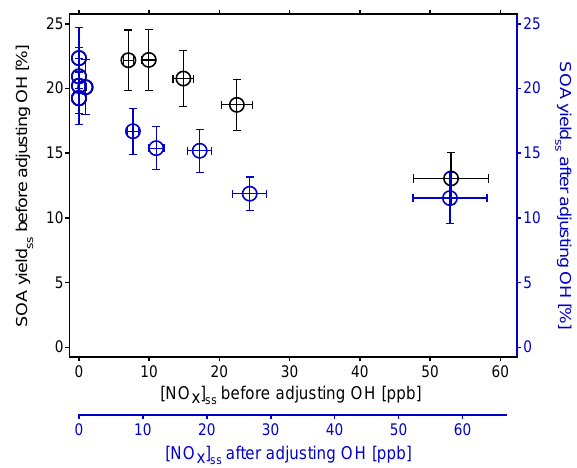
Figure 6. Comparison of [OH] before (black squares) and after (blue squares) adjusting OH concentration during steady state in NO x experiments performed under lower [NO] / [NO 2 ] ratio. The errors in [OH] and [NO x ] were estimated to be ± 20 and ± 10% respectively.